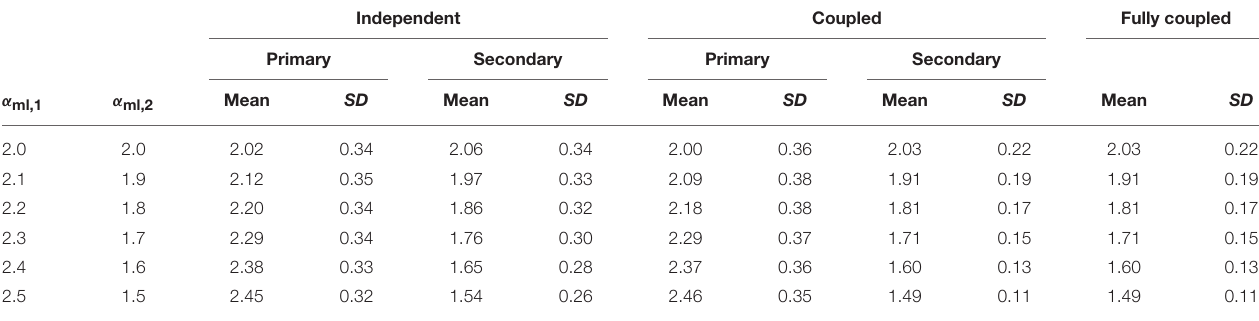
TABLE 6 | Means and standard deviations of the recovered mixing-length values adopting an observational error of 50 K in T eff . Independent Coupled Fully